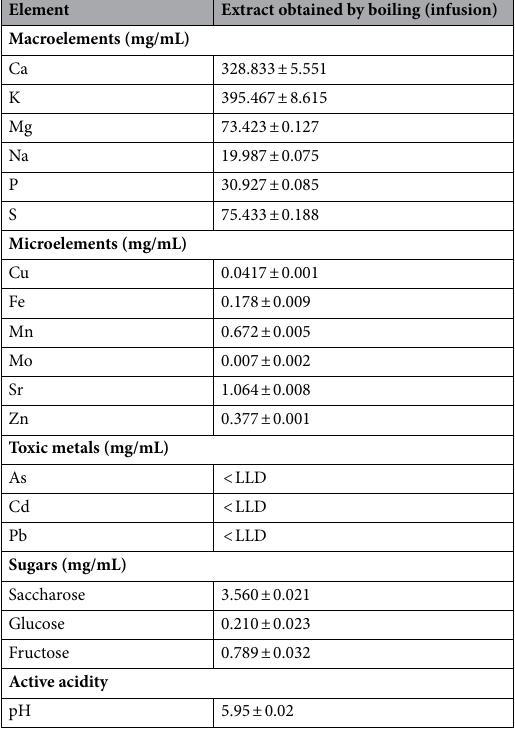
Table 2. Multielemental composition of water extracts from Levisticum officinale obtained by hot extraction (infusion) (average ± SD). < LLD—below limit of